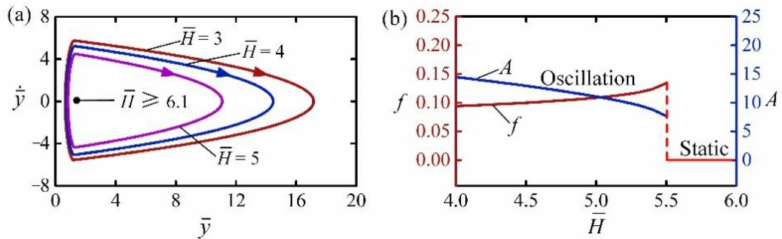
Figure 8. The effect of the dark zone on the self-jumping for I 0 = 2, C 0 = 0.3, β = 0.01, g = 1, . = 0.5, E = 500, y = 30, and = 0. ( a ) Limit cycles. ( b ) Frequency and amplitude. n g = 200, p y am 0 0 With the increase of H , the frequency of self-jumping increases while the amplitude decreases.